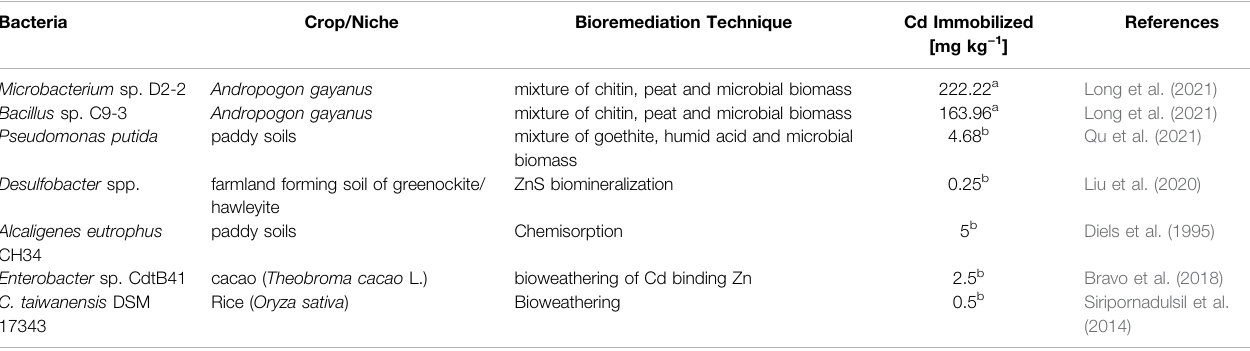
TABLE 1 | Summary of signi fi cant studies using bioremediation techniques in agricultural